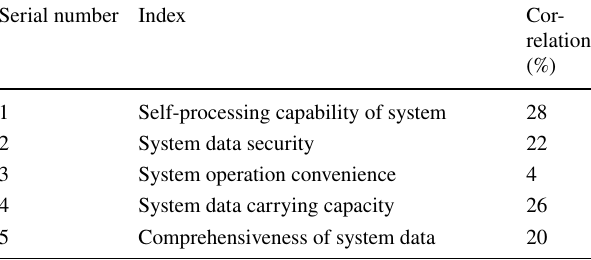
Table 3 Results of correlation